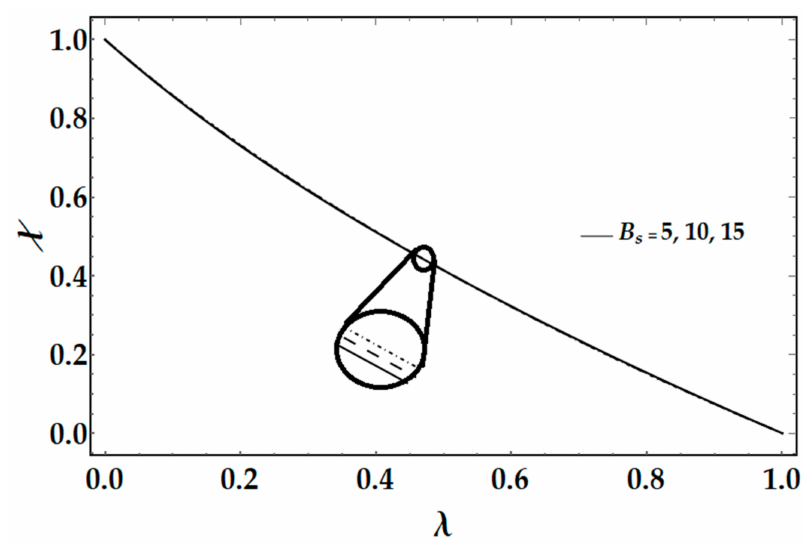
Figure 14. Implications of B s on motile microorganism density function χ ( λ )